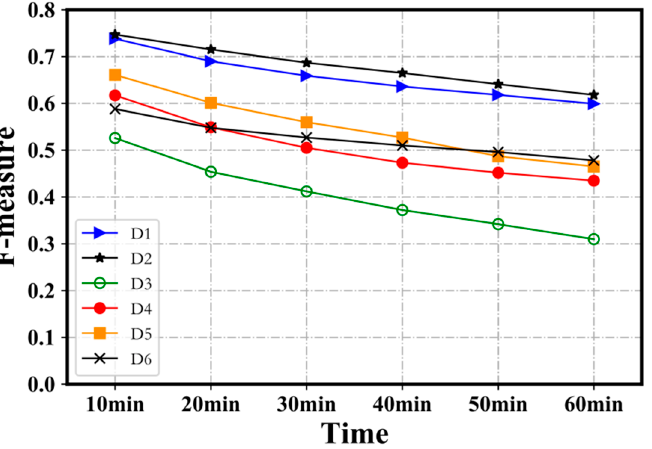
Figure 6. Performance comparison of the PDM algorithm on multiple future time points.